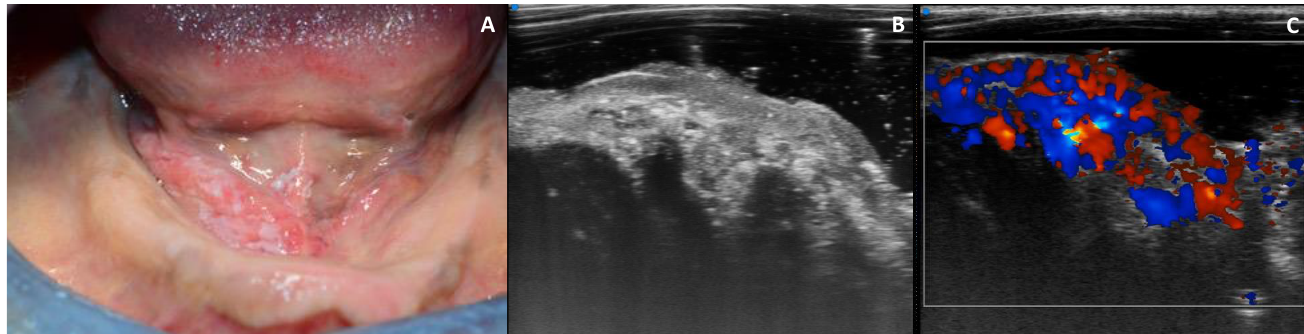
Figure 3. OSCC of the mouth floor in a 56-year-old female: ( A ) clinical aspects of the lesion; ( B ) B-mode UHFUS (ultra- high frequency ultrasound) examination, showing a lobulated exophytic lesion with characteristics of hypoechogenicity compared to the surrounding tissue; the lower margins appear blurred and the lesion seems partially extended to the underlying submucosa; ( C ) color Doppler image, showing intense (score 3) intralesional and perilesional vascularization with diffused aliasing phenomena.